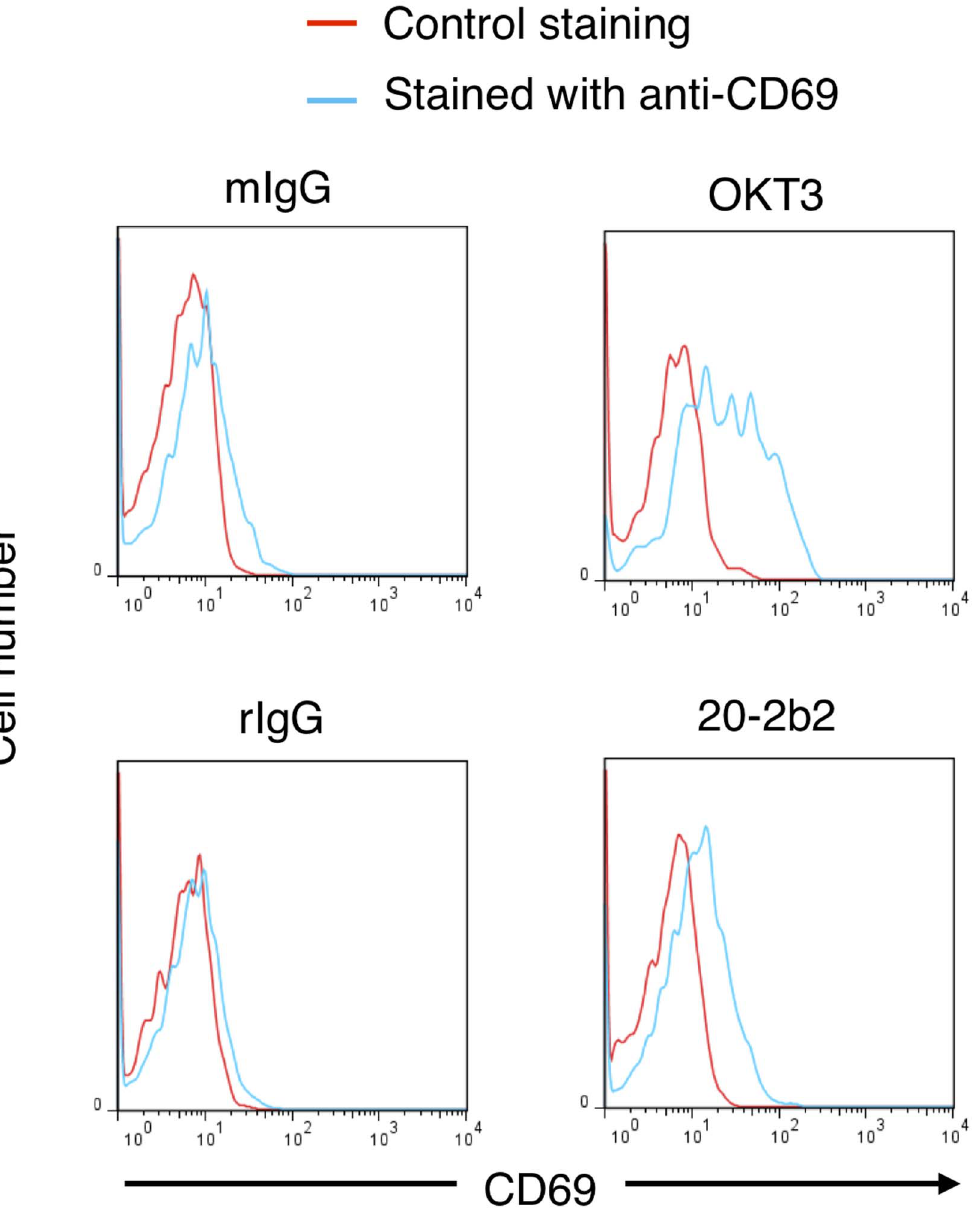
Figure 4. 20-2b2 induced the expression of CD69 on CD4 + T cells invivo . Hu-NOG mice were intravenously inoculated with one of the following Abs (20 m g/mouse); mouse IgG 2a (mIgG), rat IgG (rIgG), OKT3, or 20-2b2. Spleen cells were stained with the anti-CD4 Ab and a control Ab or anti-CD69 Ab six hours later. Cells stained with a control Ab (red) or anti-CD69 Ab (blue) in CD4 + T cells were shown as a histogram. Results are representative of three individual Hu-NOG mice.